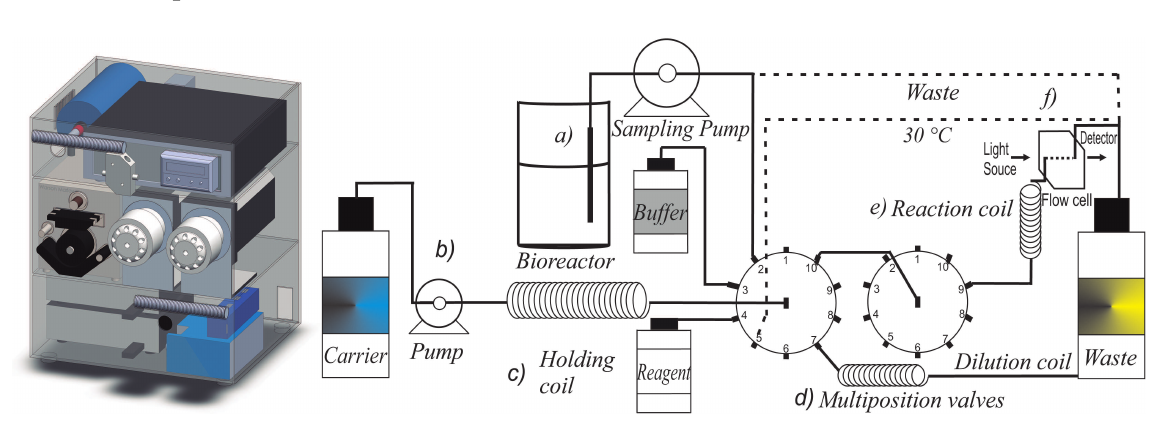
Figure 2. Description of the sequential injection analysis (SIA) system: a : sampling probe; b : mini-pump for aspiration/injection; c : holding coil; d : multiposition valves; e : reaction coil with temperature control; and f : flow cell with a light source and a spectrophotometer.